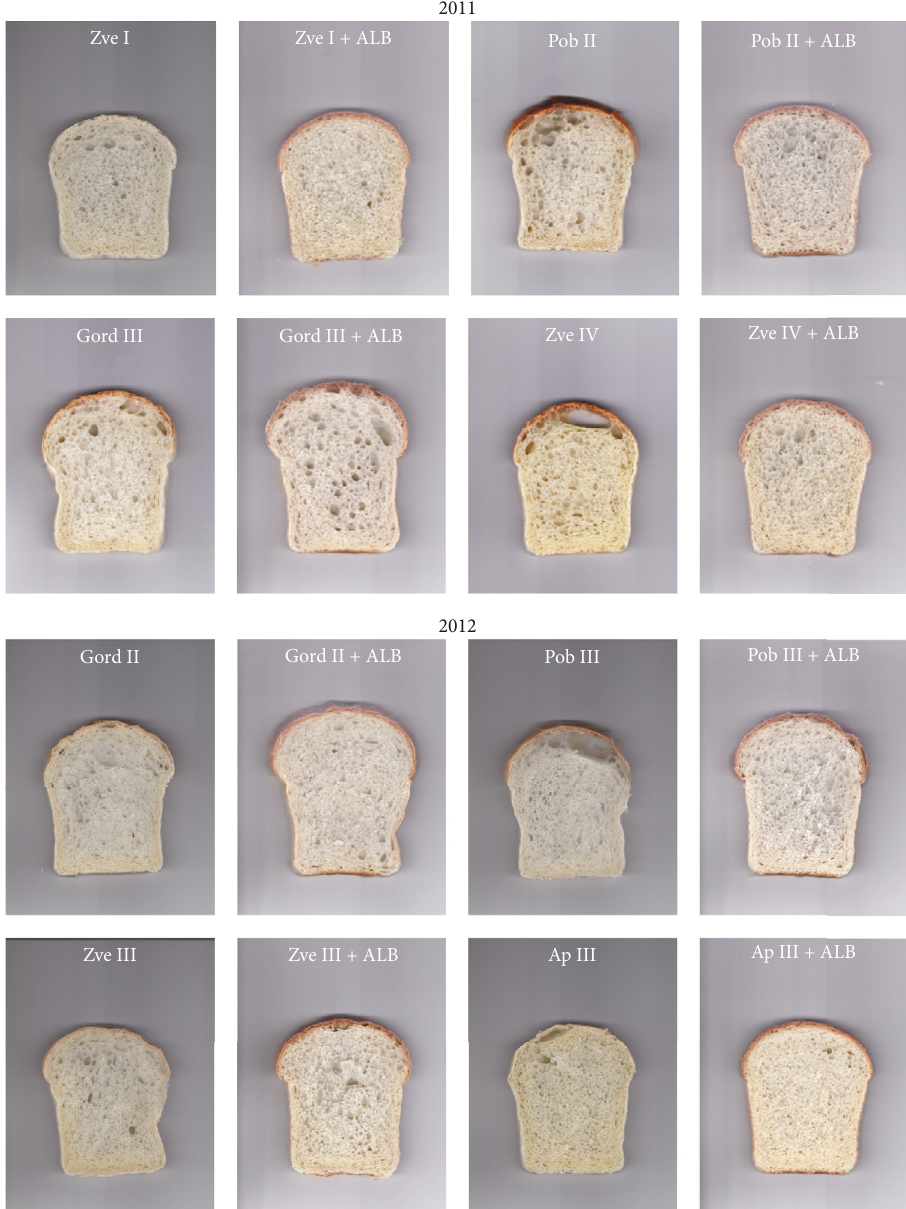
Figure 5: Cut loaves of bread produced with increased total albumin content and control samples from both production